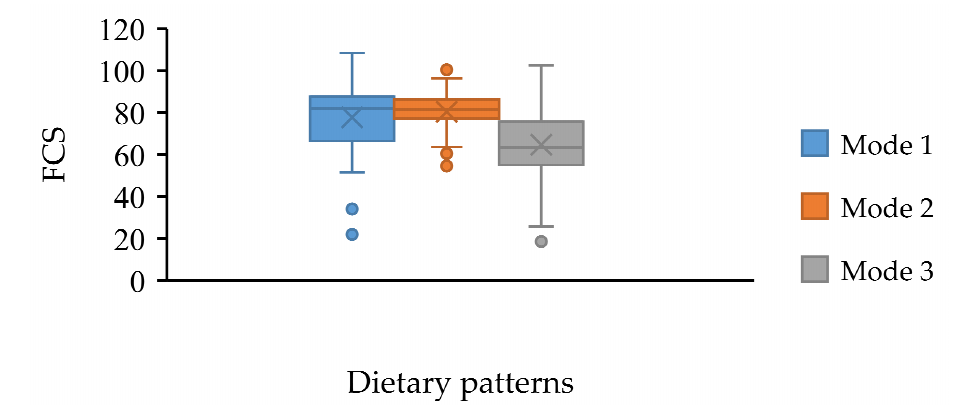
Figure 9. Relationship of dietary patterns and food consumption scores. Proportion of Staple Food Consumption Frequency and FCS